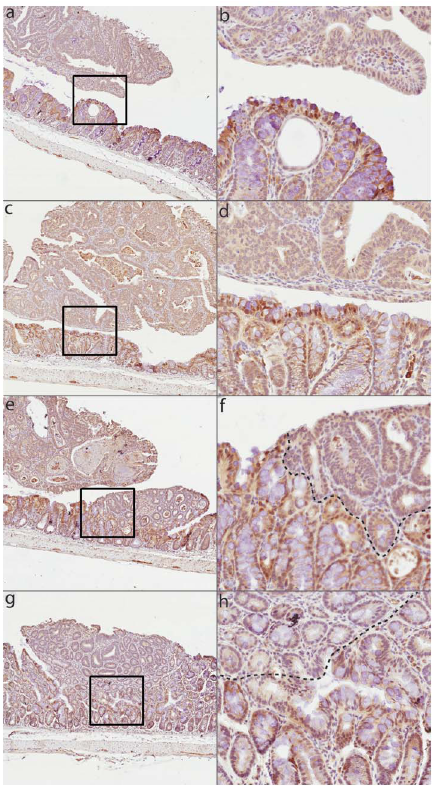
Figure 7. Nfkb1 protein expression in tumors and adjacent normal mucosa. Representative immunohistochemical staining (IHC) for p105/p50 Nfkb1 protein in tumors and adjacent colonic epithelium from mice carrying homozygous A/J-haplotype at Ccs3. 5 6 magnifica- tion (a, c, e, g) and corresponding 20 6 magnification (b, d, f, h) are shown for five representative